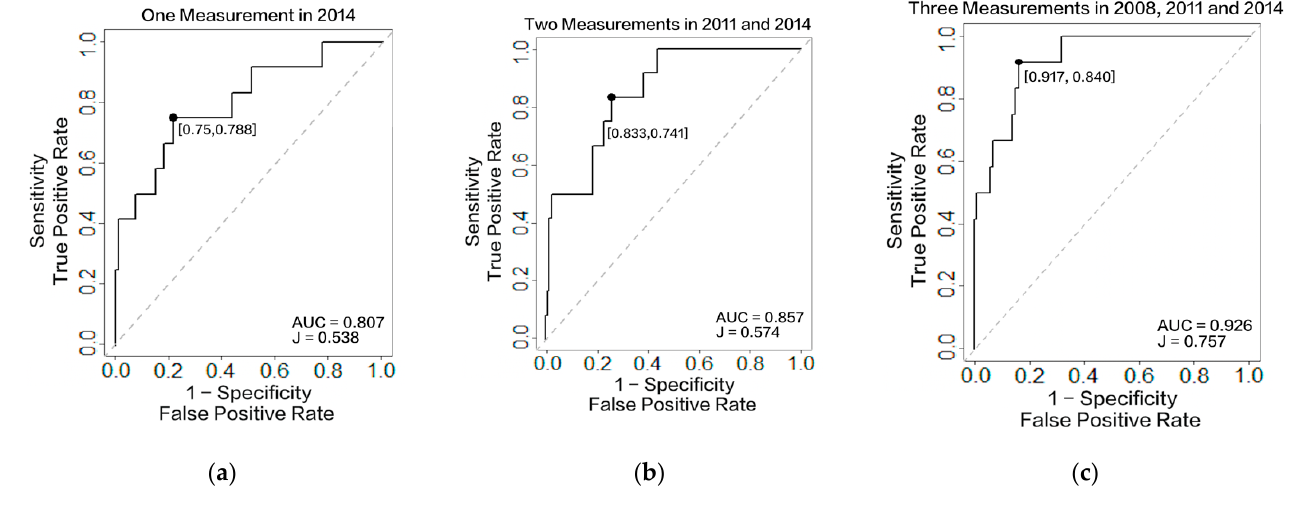
Figure 3. ROC curve for patients who were not identified as having had a stroke in 2014. The x -axis is the false positive rate, calculated as (1 – specificity), and the y -axis is the true positive rate, calculated as sensitivity. ( a ) ROC curve with one measurement in 2014; ( b ) ROC curve with two measurements in 2011 and 2014; and ( c ) ROC curve with three measurements in 2008, 2011, and